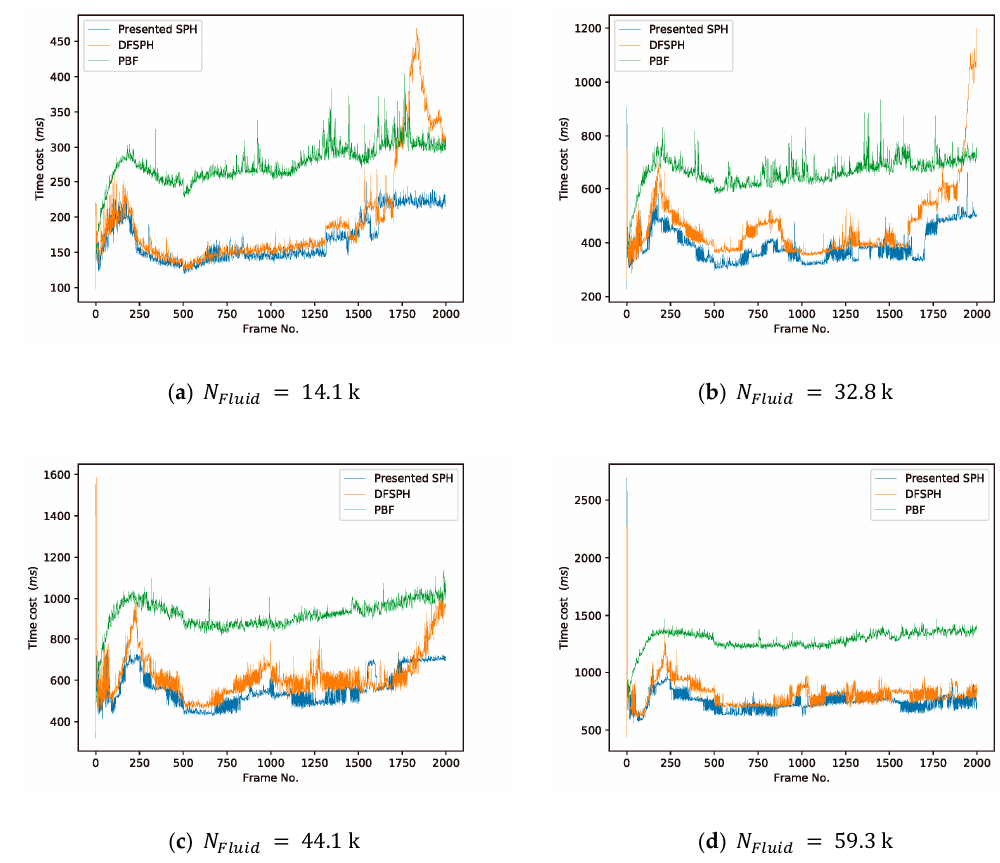
Figure 2. Time cost comparison of the first 2000 images in the dam break scene with different particle numbers. N Fluid denotes the number of fluid particles. The green, orange, and blue curves in ( a – d ) represent the time cost of PBF model, DFSPH model, and our SPH model, respectively.